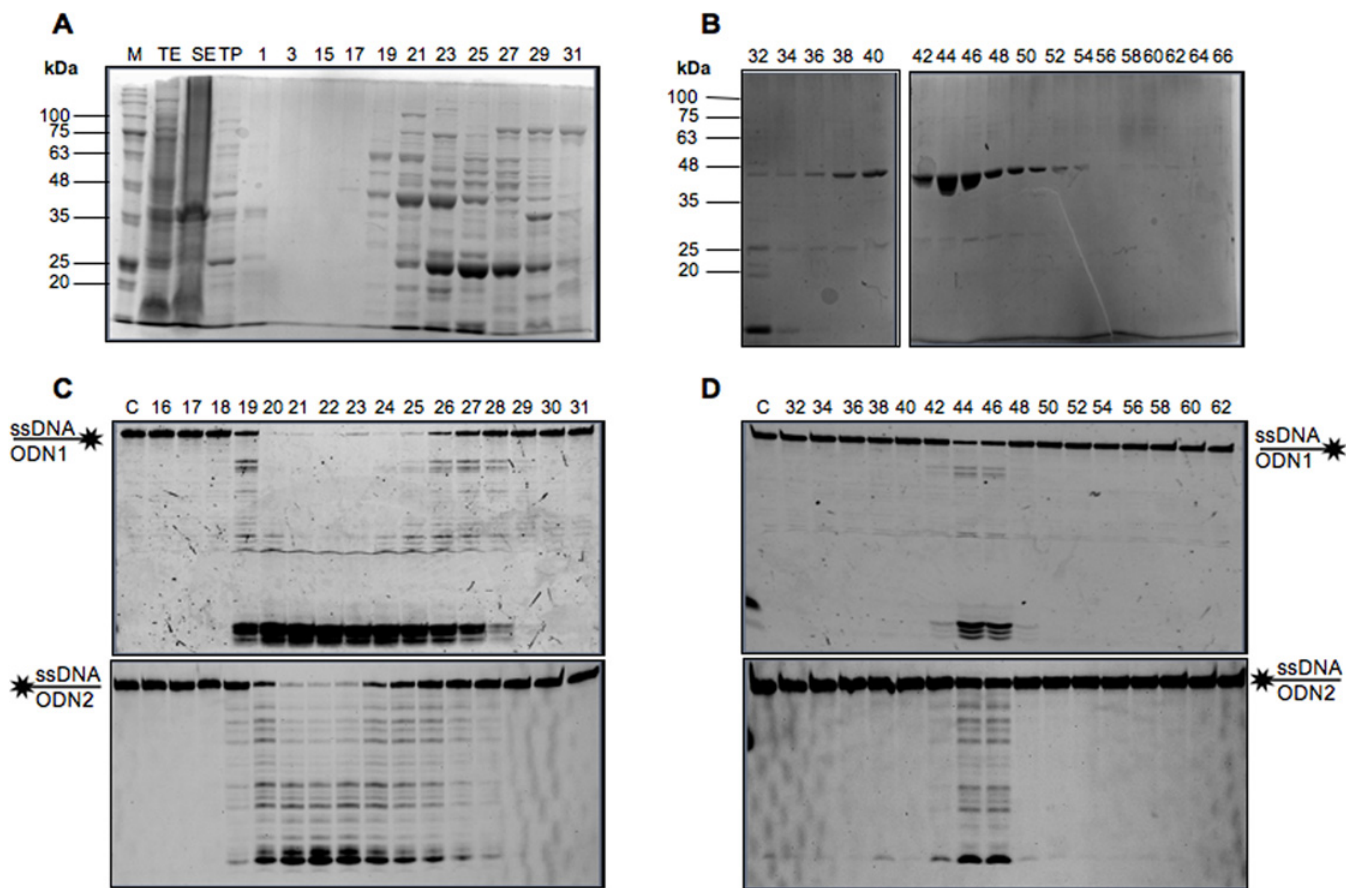
Fig 1. Analysis of S . solfataricus NurA purification and activity profile. (A) Anion exchange chromatography analysis using a MonoQ column. 20 μ l of NurA elution fractions were loaded on SDS-PAGE, on the top of the gel are reported the elution fraction numbers. Markers (M), total extract (TE), soluble extract (SE), thermo-precipitated fraction (TP). (B) Affinity chromatography elution profile using a Heparin column. 20 μ l of each fraction, whose number is reported on the top of the gel, were loaded on SDS-PAGE. Nuclease activity profile of NurA eluted from MonoQ column first (C) and Heparin column (D) after. 7 μ l of each fraction, whose number is reported on the top of the gel, were tested for their nuclease activity using both ODN1 (top) or ODN2 (bottom) substrates as described in Material and Methods. Lane C is a control lane in which no protein was added in the mixture assay.